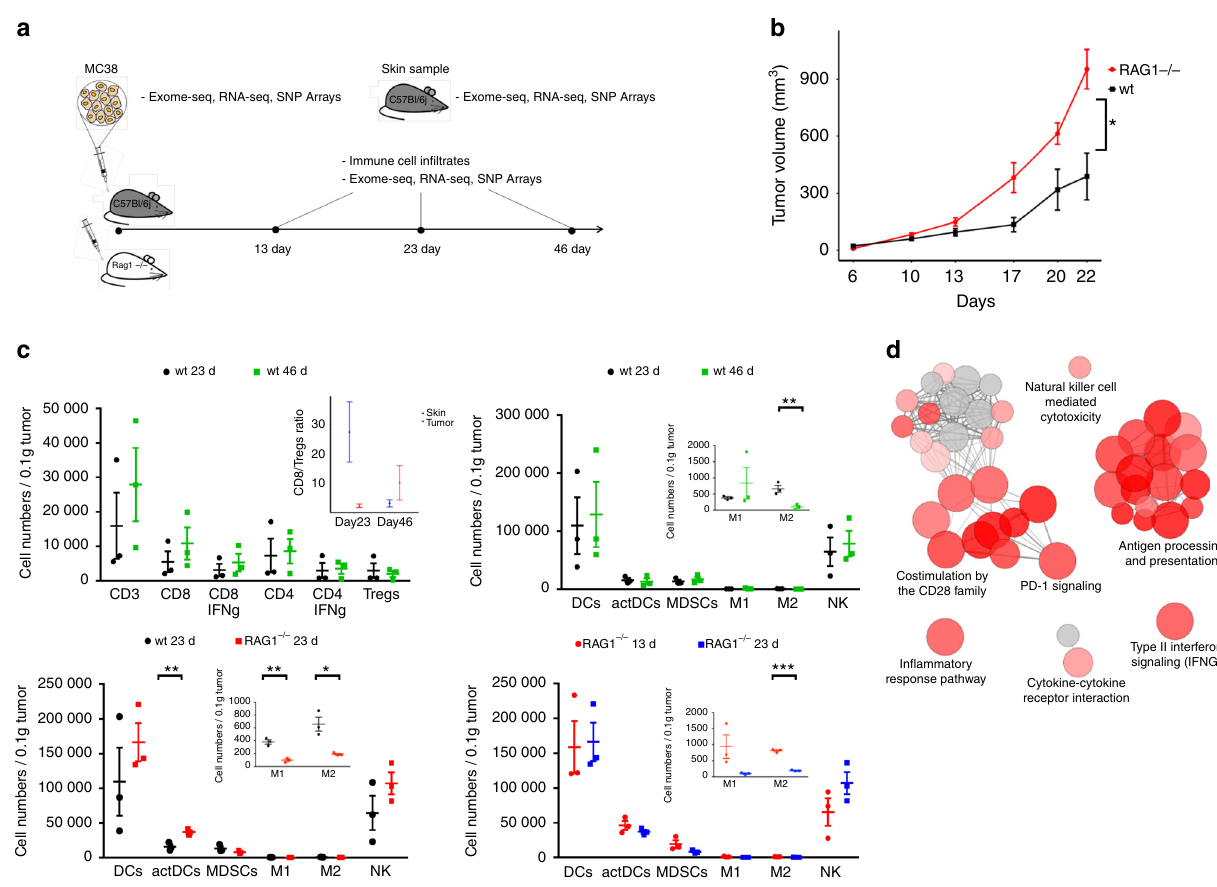
Fig. 2 Tumor progression and tumor-in fi ltrating immune cells in wild-type and RAG1 − / − mice. a Schematic diagram of the experimental setup. b Tumor growth curves of 5 × 10 4 MC38 cells inoculated into C57Bl/6 wild-type ( n = 10) and RAG1 − / − mice ( n = 4). c Tumor-in fi ltrating lymphocytes in wild-type and RAG1 − / − mice analyzed by fl ow cytometry. b , c The data are presented as the mean ± SEM, analyzed by a two-tailed unpaired Student ’ s t- test. Statistical signi fi cance is indicated as * p < 0.05, ** p < 0.01, *** p < 0.001. d Enriched functions and pathways of the signi fi cantly differentially expressed genes in tumors of the wild-type vs RAG1 − / − mice taken at day 23. The network is created using ClueGO. The pathways are functionally grouped based on the kappa score and the most signi fi cant term of each group is highlighted. The size of the nodes shows the enrichment signi fi cance after Bonferroni